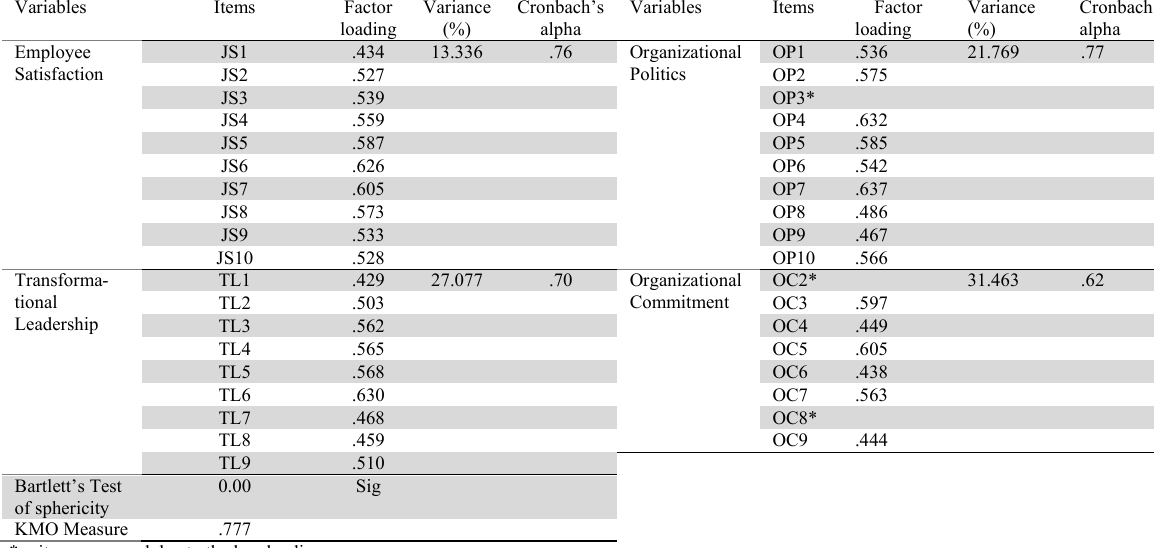
Factor analysis and reliability